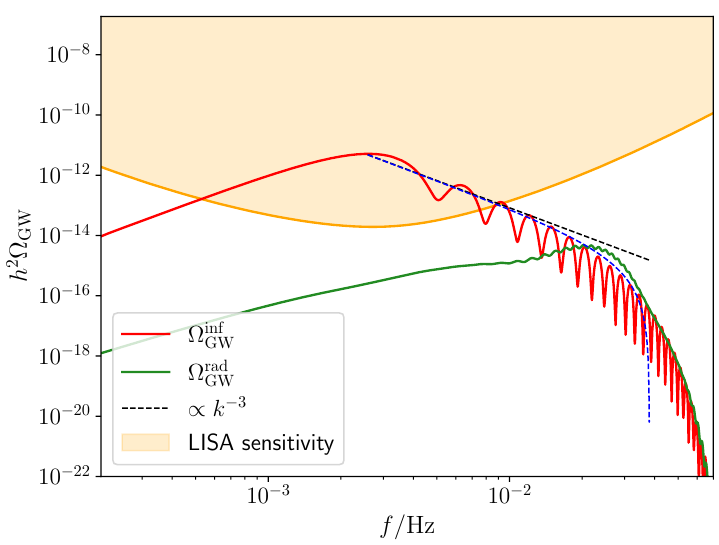
Figure 8 . Ω rad and Ω inf computed for the parameter choice space highlighted with a cross in GW GW figure 7, i.e. ( γ, p ) = (21 . 2 , 5) or ( η ⊥ , δ ) = (23 . 7 , 0 . 225) . For illustrative purposes the time of the feature has been adjusted so that the signal peaks in the LISA frequency band. We also show the approximate envelope of Ω inf , cf. eq. (4.48) (dashed blue), and highlighted the power law f − 3 GW falloff after the peak (dashed